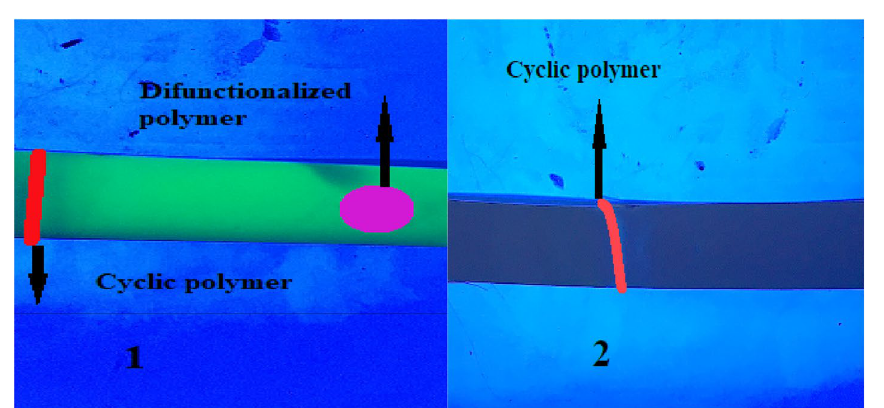
Figure 18. ( 1 ) TLC of cPNIPAAM produced in emulsion of SC-CO 2 in water; ( 2 ) TLC of cPNIPAAM produced by cyclization in homogeneous phase of SC-CO 2 and